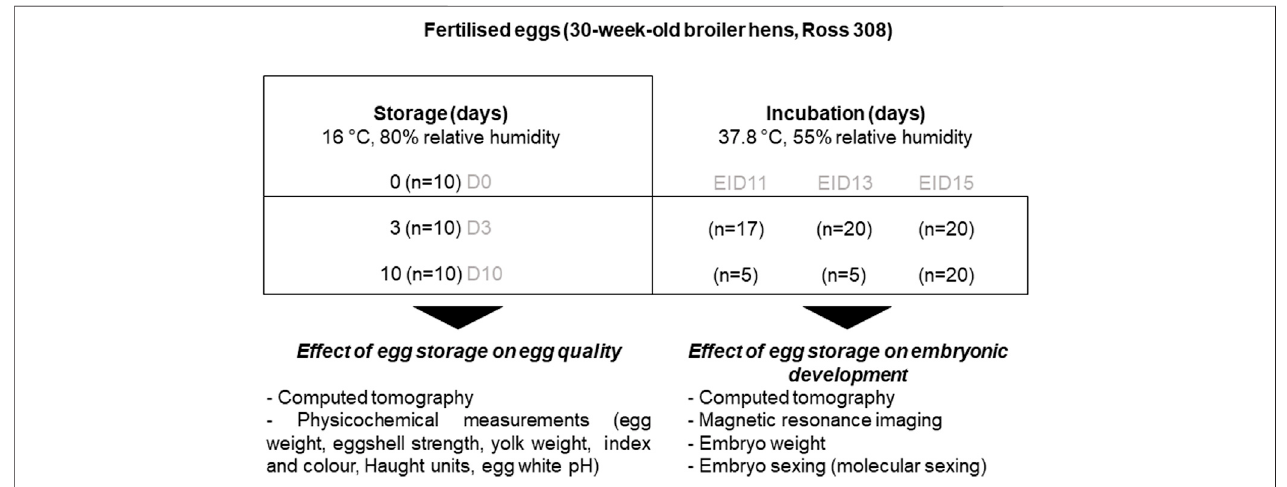
FIGURE 2 | Experimental design. The internal quality of freshly laid eggs (day of laying, D0) and eggs stored for three (D3) or 10 days (D10) was measured to evaluatechangesoccurringduringstorage(leftpanel).Aseriesofeggsstoredforthreeor10 dayswerefurtherincubatedfor11(EID11),13(EID13)or15(EID15)daysto analyse the impact of storage on embryonic development (right